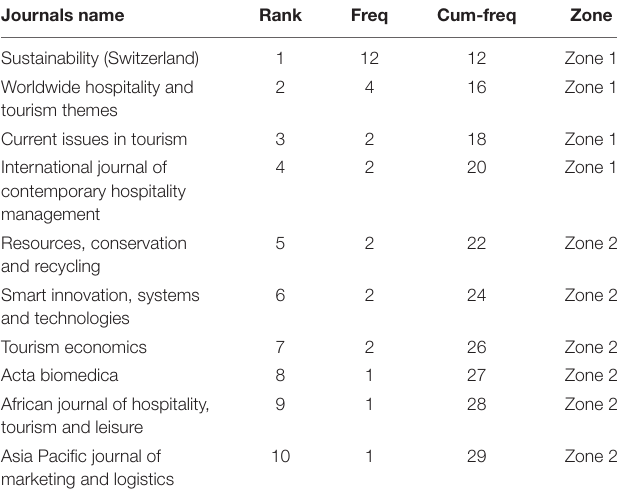
TABLE 2 | Journal ranking based on Bradford